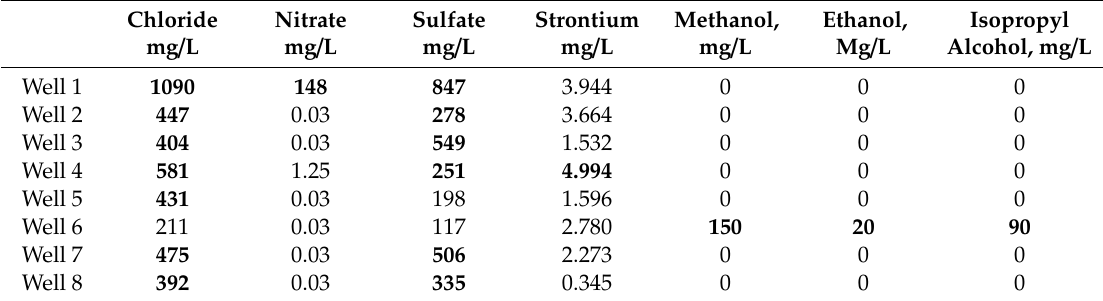
Table 6. List of wells that had exceedances of drinking water standards and the parameters in bold that exceeded US EPA